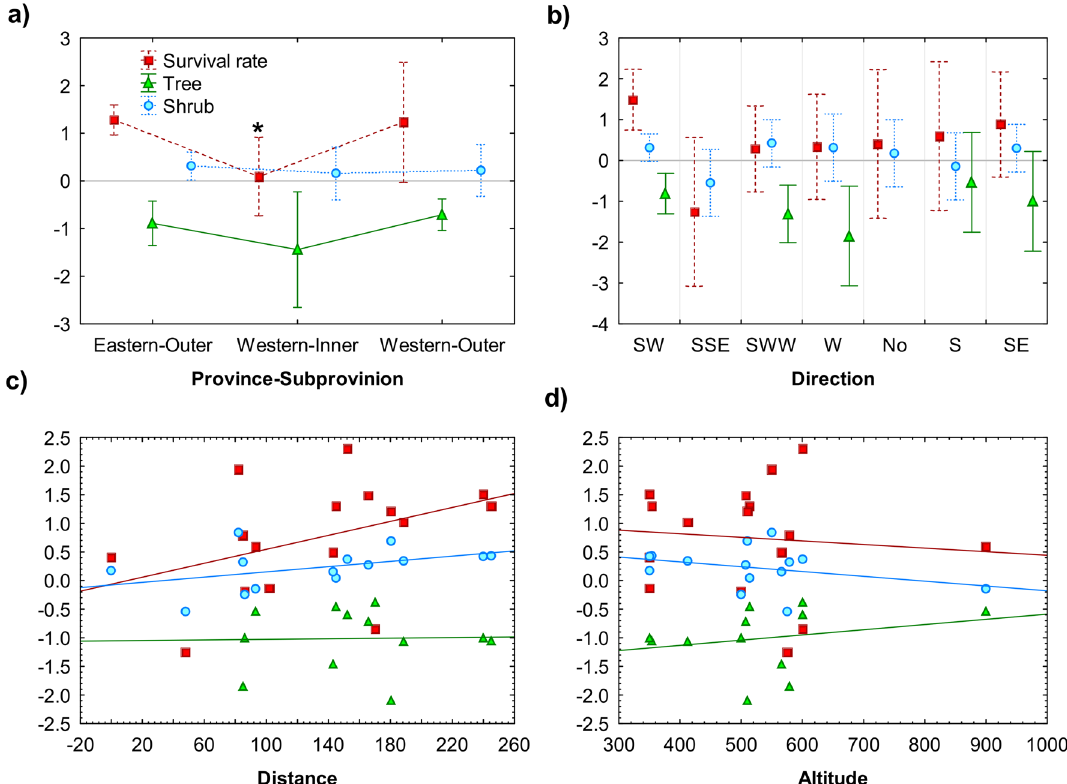
Figure 5. Survival and growth form of the curly birch progenies according to characteristics of the parental environment: ( a ) geomorphological unit, ( b ) transfer direction, ( c ) transfer distance (km), and ( d ) altitude (m asl). The survival rate, percentage of trees and shrubs are expressed on the y-axis as logit transformed values, vertical bars denote 0.95 confidence interval, * - marks significantly different